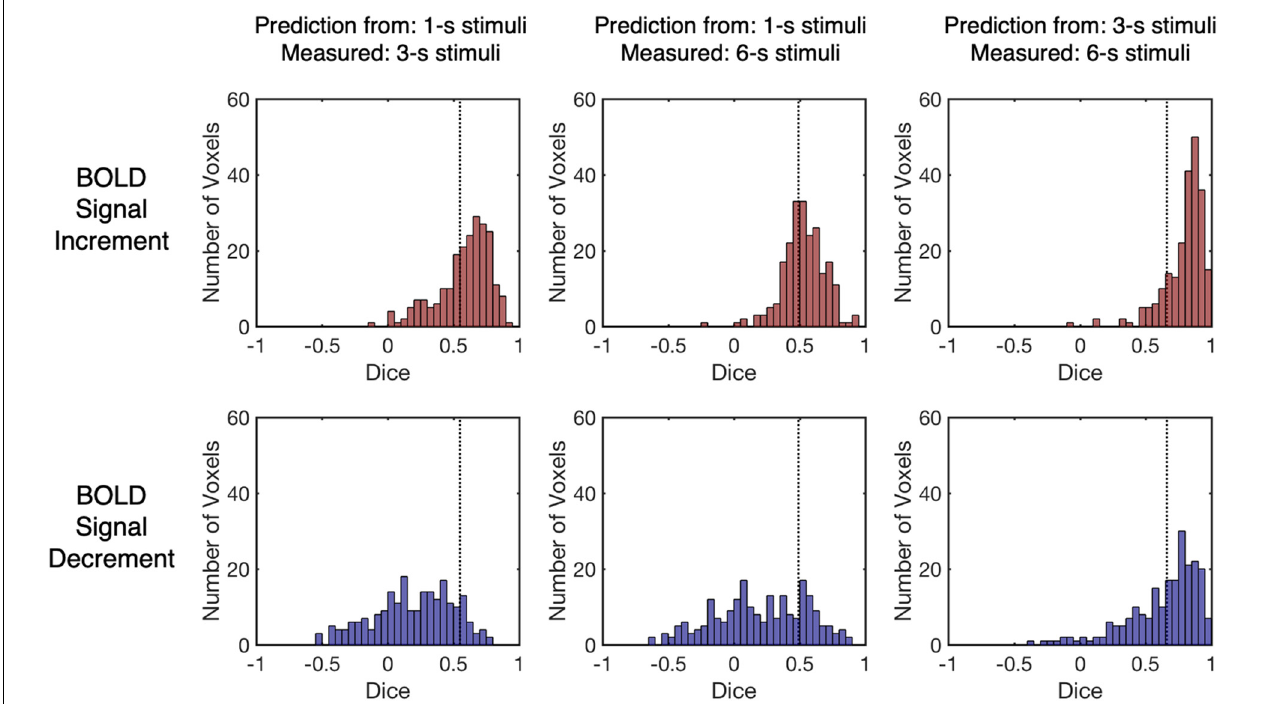
FIGURE 4 | The distributions of the Dice index for different BOLD response types and stimulus durations. The Dice index describes the similarity between measured BOLD response and its linear prediction. The vertical dashed lines indicate the upper thresholds for chance levels (false positive rate = 0.05, one-tailed, corrected), and having a Dice index above chance level suggests that the response to the short stimulus can predict response to the longer stimulus in a linear way. Each data point refers to the Dice index of one selected voxel. Each distribution includes all selected voxels from all participants (same for the figures